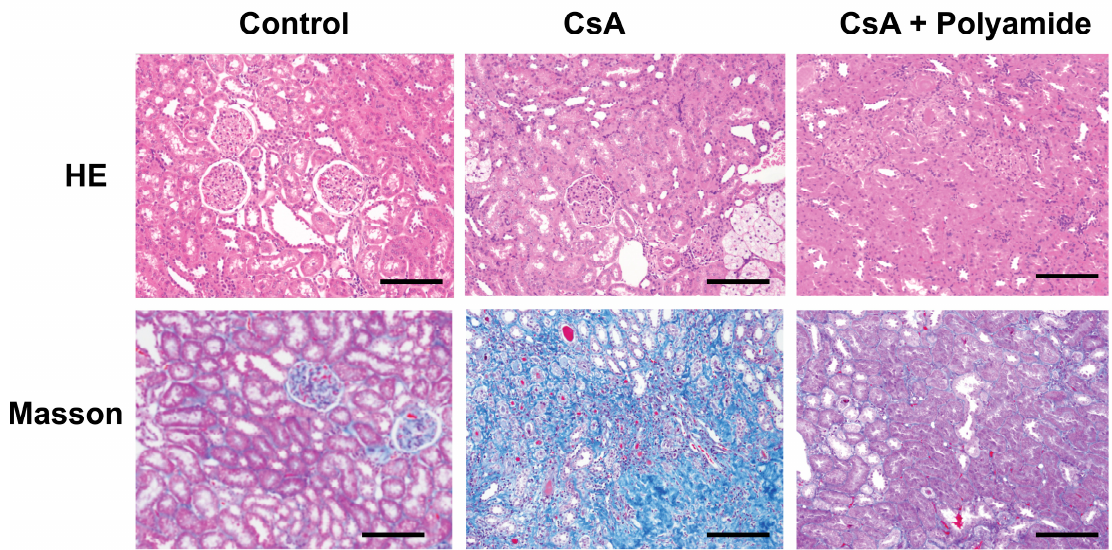
Figure 3. The effects of pyrrole-imidazole polyamide targeting human TGF- β 1 (Polyamide) on fibrosis in marmosets with cyclosporin A (CsA)-induced nephropathy. Male marmosets were housed and fed with a 0.05% NaCl and 0.05% magnesium diet and subcutaneously injected with CsA (40 mg/kg/day) for eight weeks. Marmosets with CsA-nephropathy were intravenously injected with Polyamide (1 mg/kg/week for four weeks) from four weeks after the start of CsA injection. Sections (thickness: 4 µm) of kidney tissue samples were stained with hematoxylin-eosin (HE) and Masson trichrome (Masson).